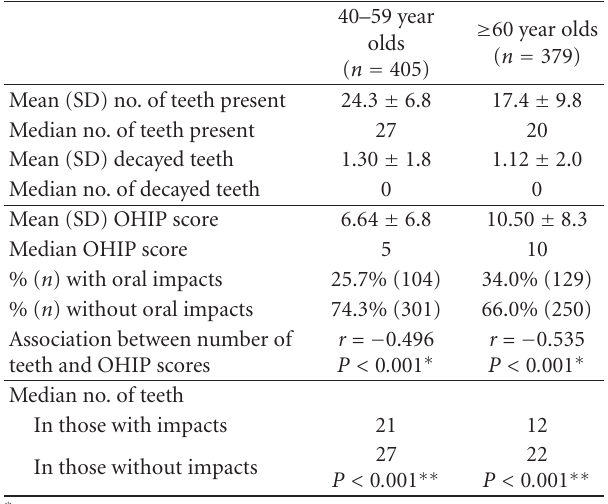
Table 1: Teeth present and oral impacts in the sample.